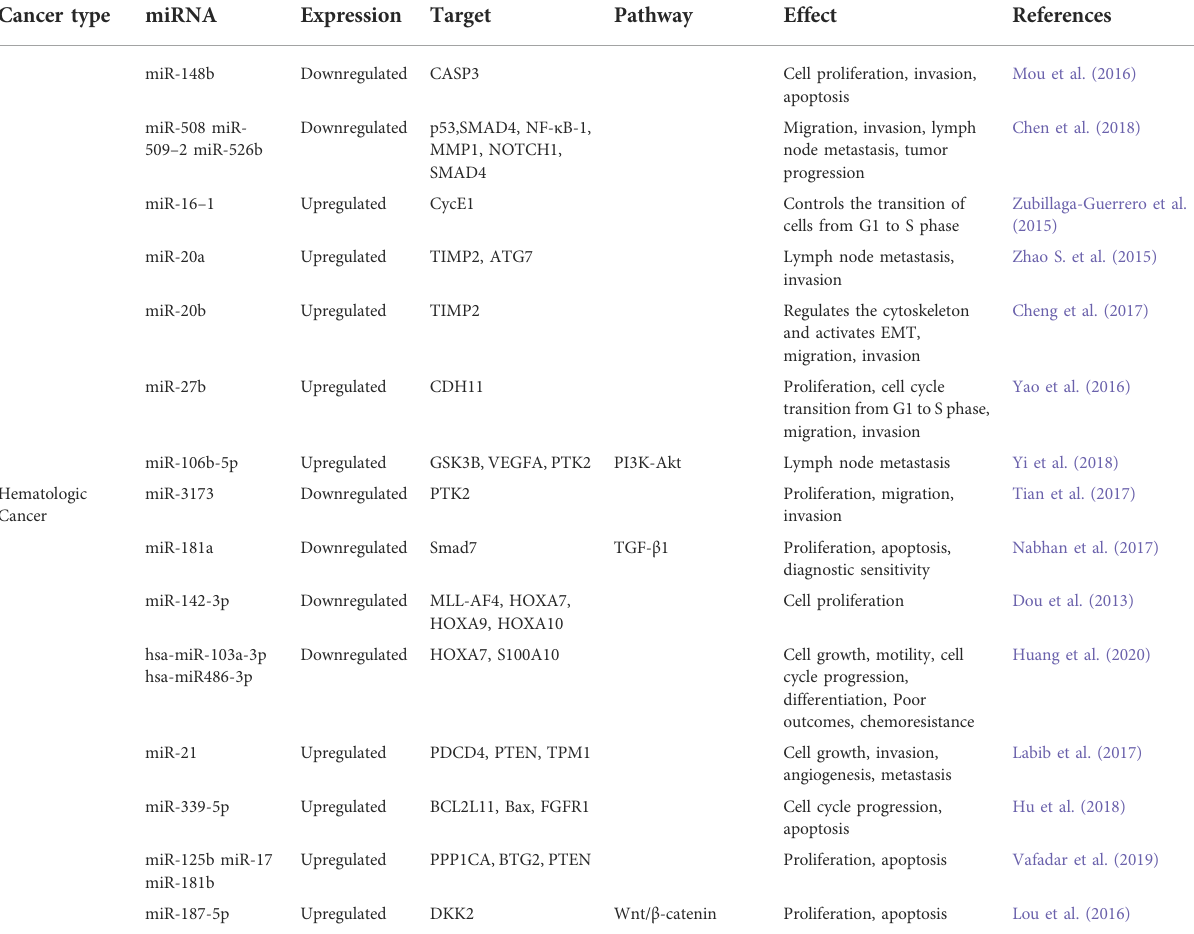
TABLE 1 ( Continued ) Examples of miRNAs and their roles in different